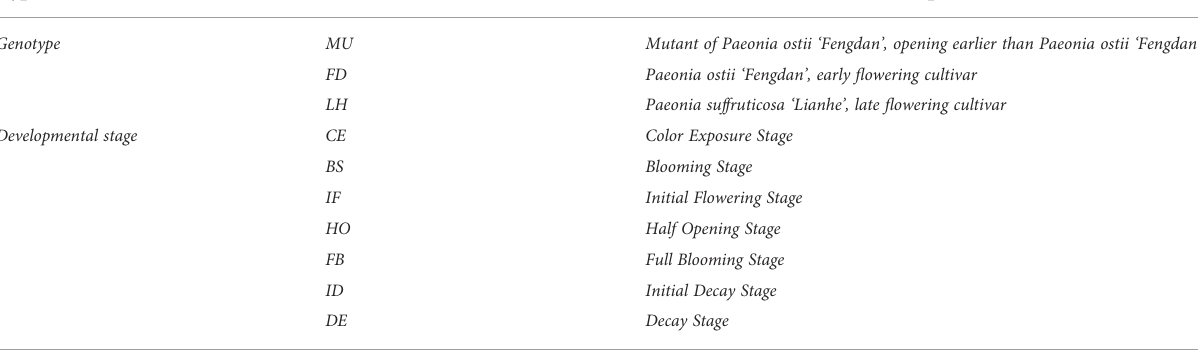
TABLE 1 Summary of the abbreviations used for sample names and library